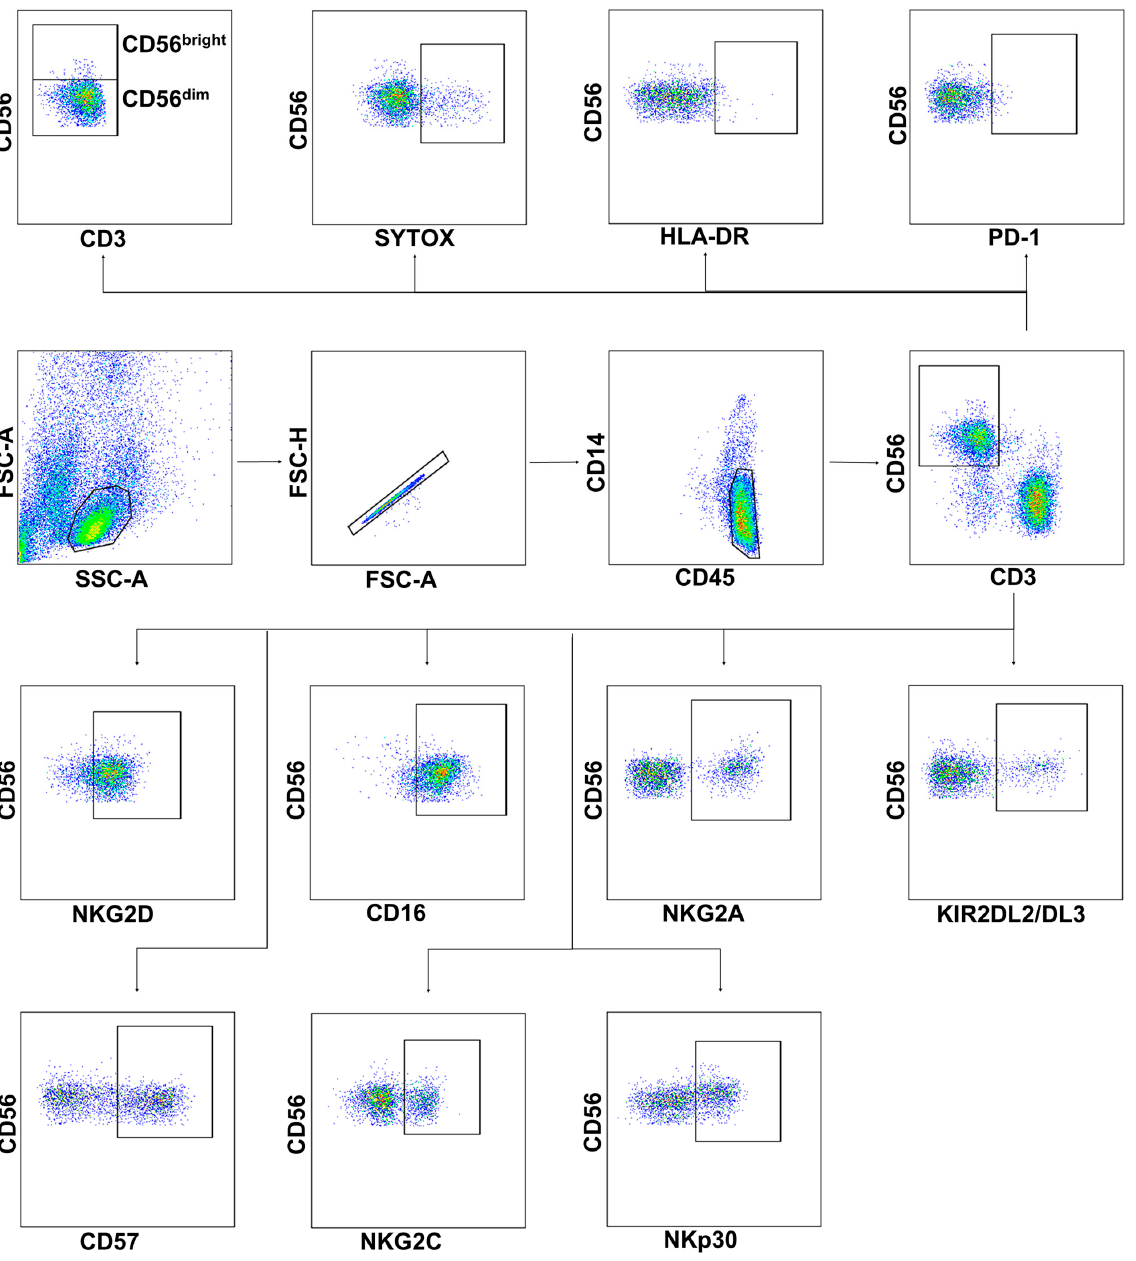
Figure 1. The gating strategy for cytometric analysis of NK cells in PBMC samples. Surface expression of PD-1, HLA-DR, NKG2D, CD16, NKG2A, KIR2DL2/DL3, CD57, NKG2C, and NKp30 was analyzed in NK cells by flow cytometry after staining with fluorescent-labeled specific monoclonal antibodies. NK cells were defined as CD3 − CD56+ cells in CD45highCD14 − cells in the FSC-SSC lymphocyte gate; CD56bright and CD56dim NK cells were determined. SytoxBlue staining was used to detect dying cells.